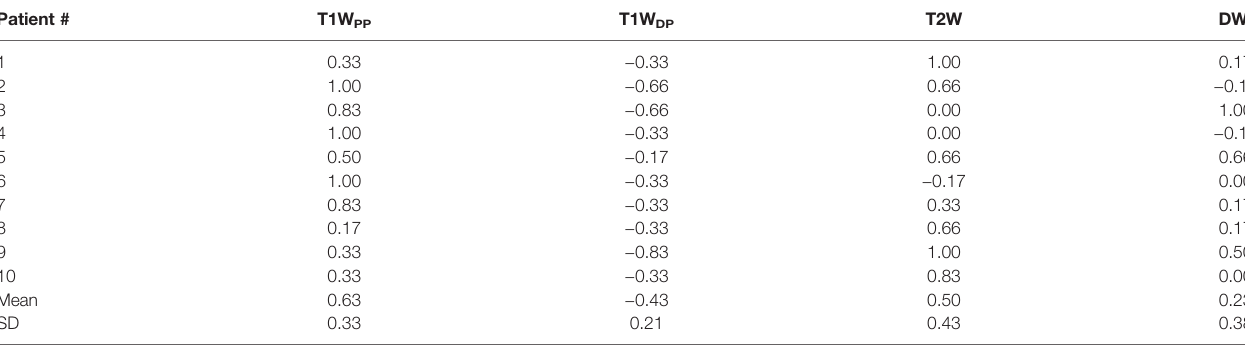
TABLE 2 | Input MRI weight coef fi cients for the fused MRI with optimal tumor CNR of each patient. Patient